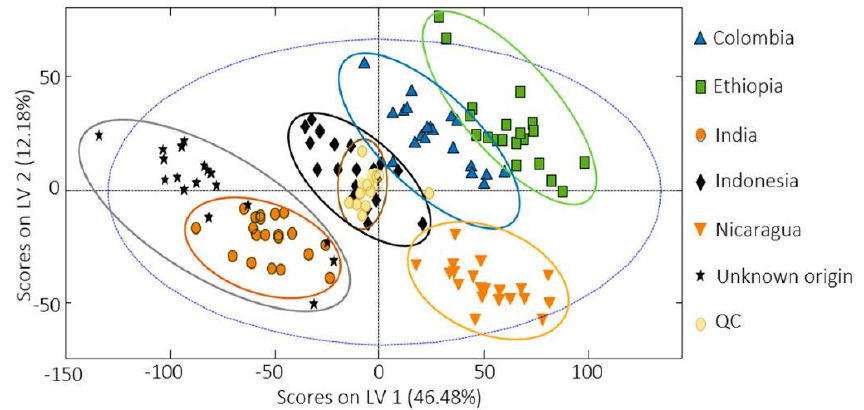
Figure 8. PLS-DA differentiation of coffee samples based on their geographical origin [1].